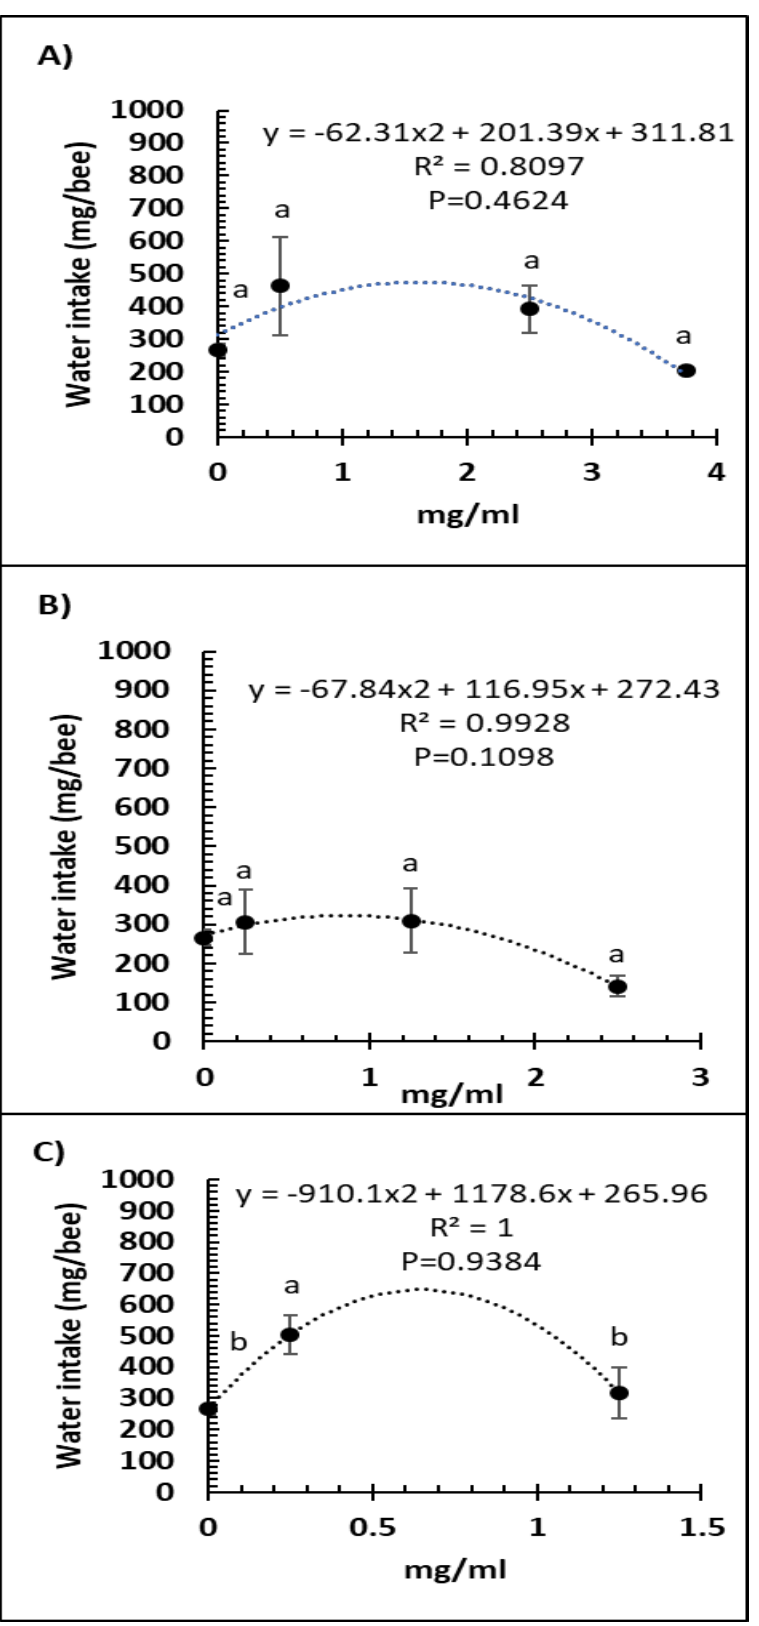
Figure 4. Relationship between water intake and concentration (mg/mL) of the probiotics Vetafarm Probotic ( A ), Protexin Concentrate single-strain ( B ), and Protexin Concentrate multi-strain ( C ), fed to N. ceranae -infected honey bees. Treatments followed by the same letter are not significantly different.